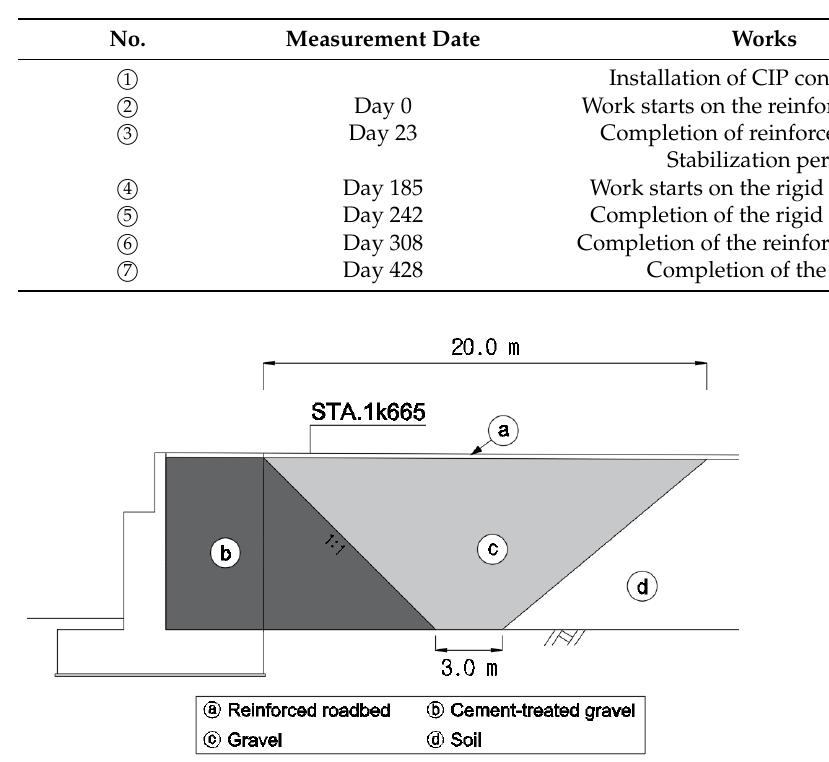
Table 3. Construction working schedules.